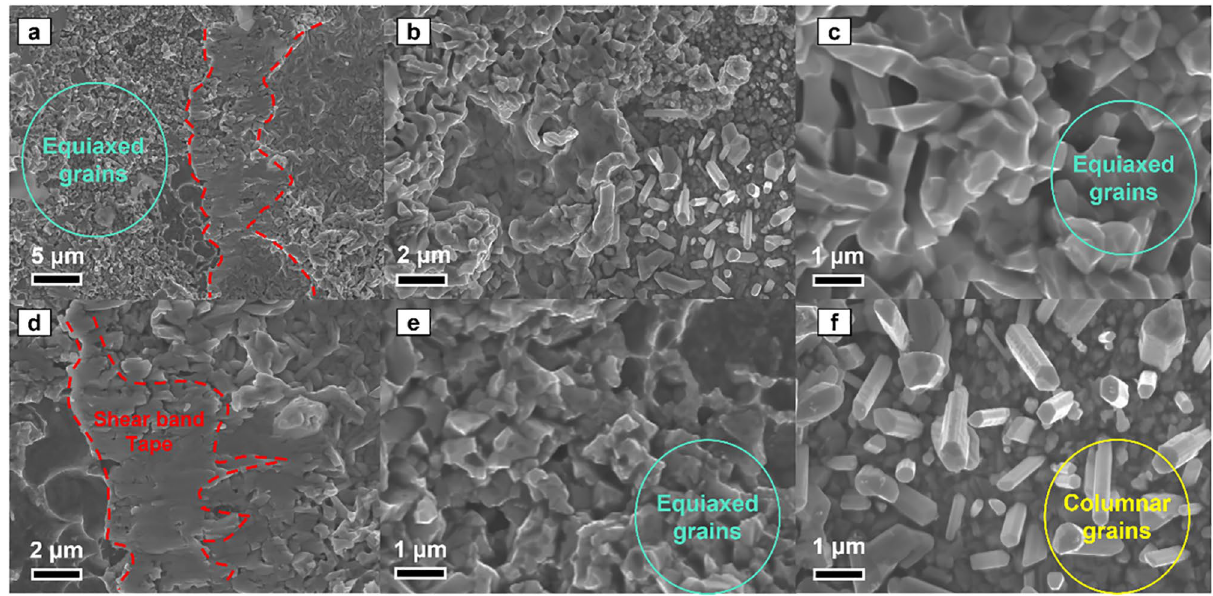
Figure 11. SEM image of fracture morphology ( a ) shear bands exist in the mixed zone of equiaxed grains and columnar grains, ( b ) equiaxed grains, ( c ) equiaxed grains, ( d ) shear band tape, ( e ) equiaxed grains, ( f ) columnar